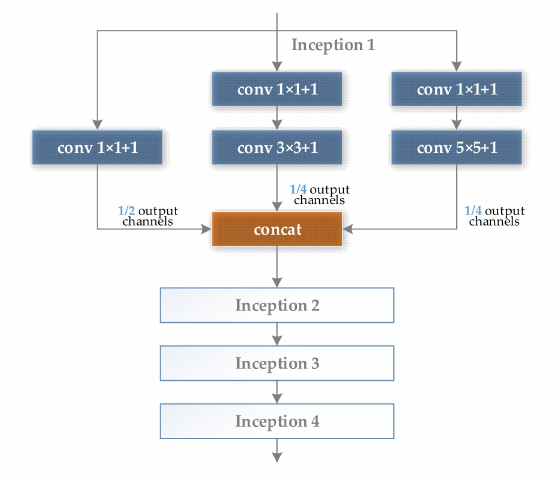
Figure 2. Four Inception modules in series